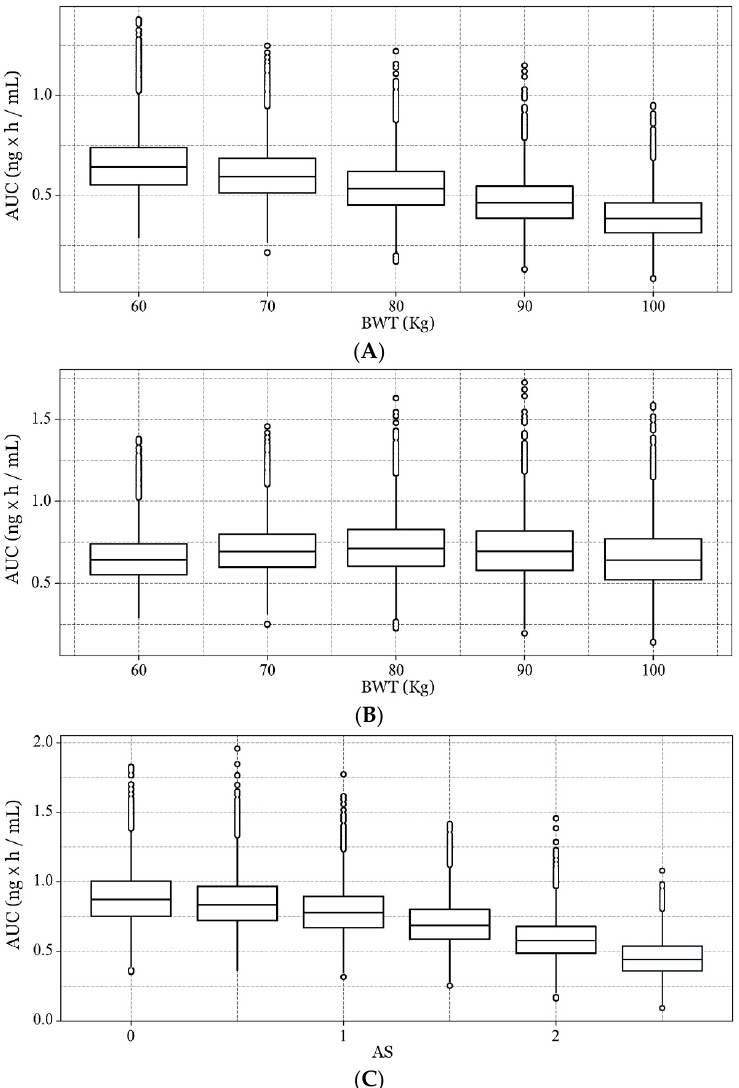
Figure 5. Simulated primaquine (PQ) area-under-the-curve (AUC PQ ) in groups with different body weights (BWT). ( A ) AUC PQ after administration of a flat dose of 15 mg for the 60 kg, 70 kg, 80 kg, 90 kg, and 100 kg groups; ( B ) AUC PQ after administration of a weight normalized dose of 0.25 mg/kg (15 mg for 60 kg, 17.5 mg for 70 kg, 20 mg for 80 kg, 22.5 mg for 90 kg, and 25 mg for 100 kg); ( C ) AUC PQ versus CYP2D6 activity score (AS) for a dose of 17.5 mg administered to individuals with 70 kg body weight and 175 cm